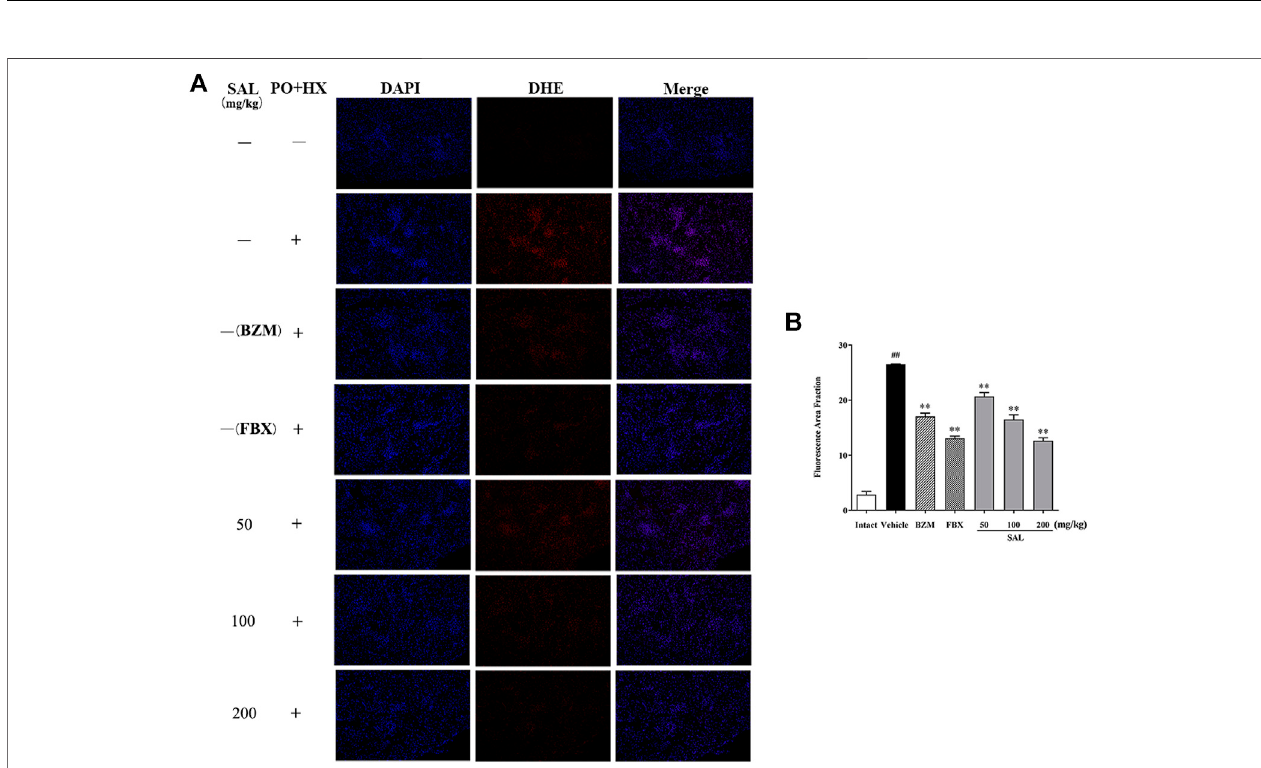
FIGURE6| EffectsofSALonmarkersofoxidativestress. (A) DHEstainingoftherenaltissues; (B) fl uorescenceareaintensity.Alldataareexpressedasmean ± SD ( n (cid:2) 3). ## p < 0.01 vs. the intact group, **p < 0.01 vs. the vehicle group.